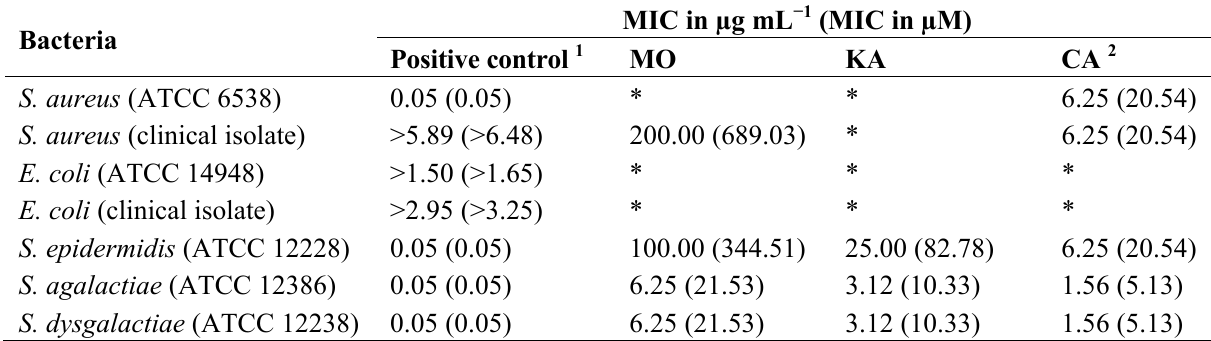
Table 1. In vitro antibacterial activity (MIC) of manool (MO), ent- kaurenoic acid (KA), and ent- copalic acid